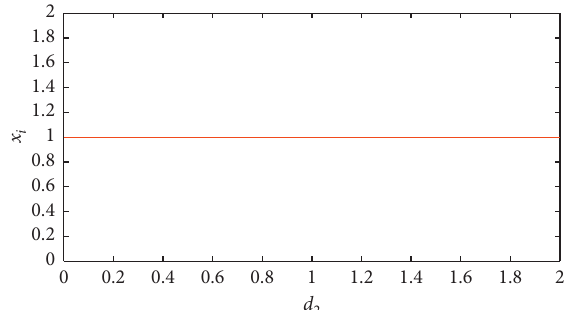
Figure 6: The bifurcation about d when p � 0 . 0004 and p � 0 .